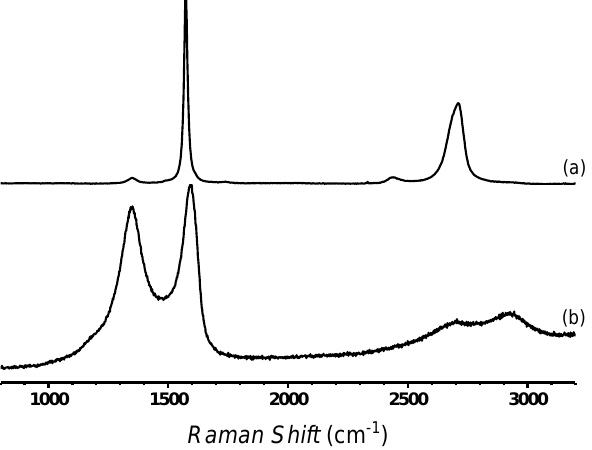
Figure 1. Raman spectra of graphite ( a ) and thermally reduced graphene oxide (TrGO) ( b ).